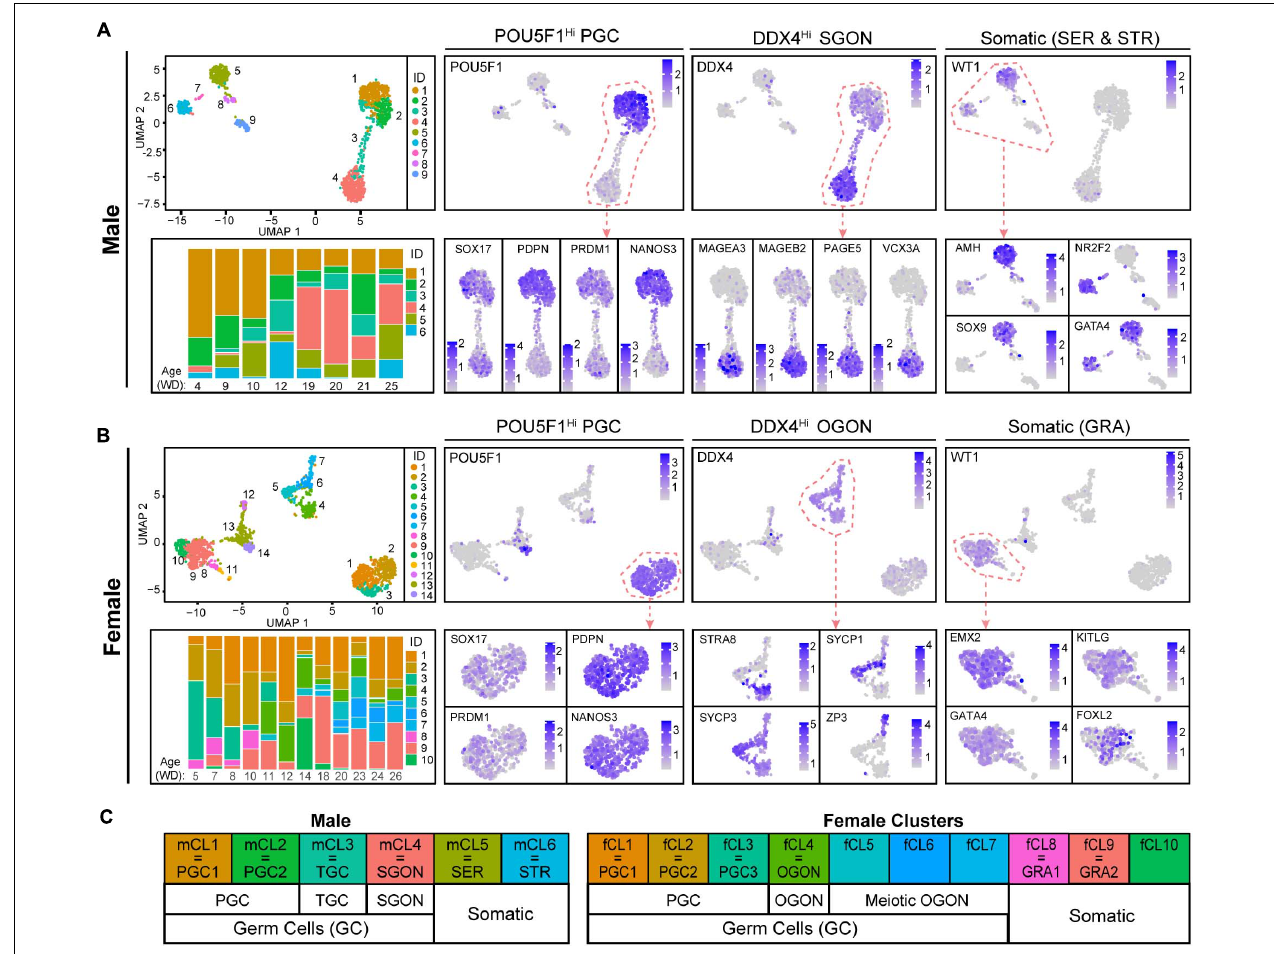
FIGURE 1 | Cell clustering in human fetal male and female gonads. (A,B) Uniform manifold approximation and projection (UMAP) visualization of cells from the human fetal testis (A) or ovary (B) showing cluster identification (ID) (top left panel) and the expression of genes of interest [log-normalized unique molecular identifiers (UMI)] for cell type identification (right side). Bottom left panels show stacked bar plots depicting relative distribution of cells in each cluster per age (weeks of development, WD) in the dataset. (C) Schematic overview of the cell types assigned to the different